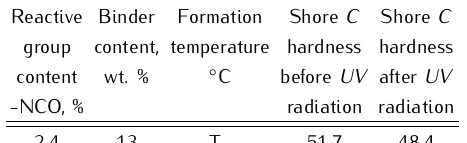
Table 3. Dependency of Shore C hardness of composite material (formation pressure P = 0.004 MPa), containing polymer binder with different reactivity (before and after UV radia- tion). Reactive Binder Formation Shore C Shore